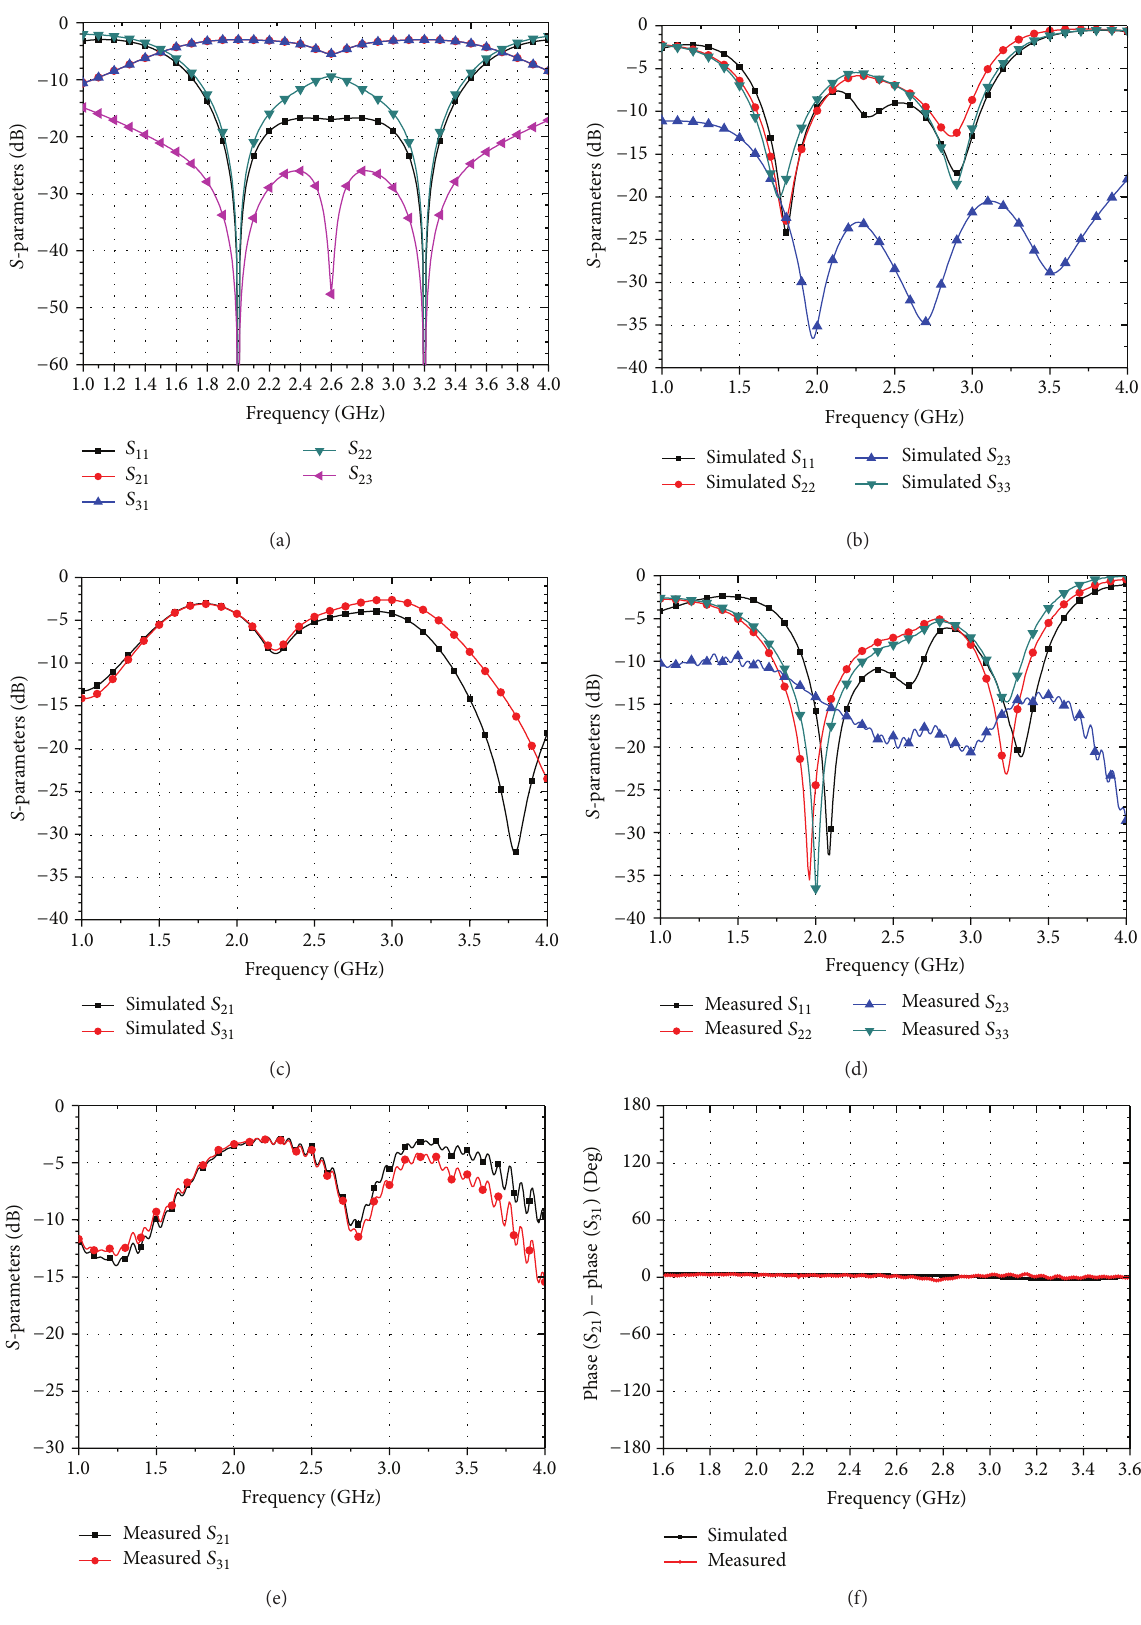
Figure 8: Scattering parameters of the fabricated divider shown in Figure 7: (a) calculated results, (b) and (c) full-wave simulated results, (d) and (e) measured results, and (f) simulated and measured phase differences